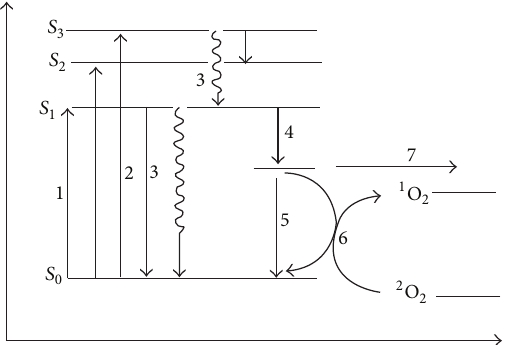
Figure 1: Photosensitizer absorbance after physical processes ((1) absorbing light; (2) fluorescence; (3) internal conversion; (4) inter- systemcrossing;(5)phosphorescence;(6)generating 1 O 2 ;(7)proton or electron